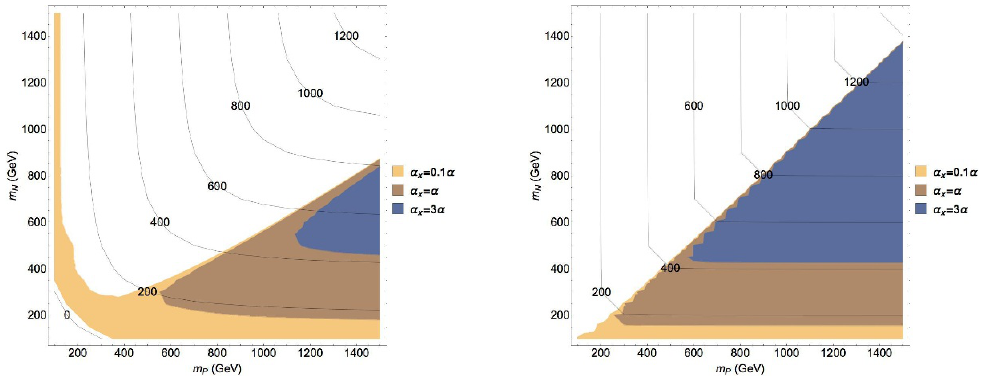
Figure 3 . Regions in the m P - m N where the thermal 1 relic density exceeds the observed value. The plot on the left has (cid:21) = 1, while the plot on the right corresponds to (cid:21) = 0 : 1. The di(cid:11)erent shadings show the exclusions for (cid:11) x = 0 : 1 (cid:11); (cid:11); 3 (cid:11) . Also shown are contours of the 1 mass m 1 . to s 4 or s 2 c 2 respectively. In the event of small mixing angles, p -wave processes involving (cid:11) (cid:11) (cid:11) an s -channel Higgs can be signi(cid:12)cant. These amplitudes scale as (cid:21)s ZZ , or hh (cid:12)nal